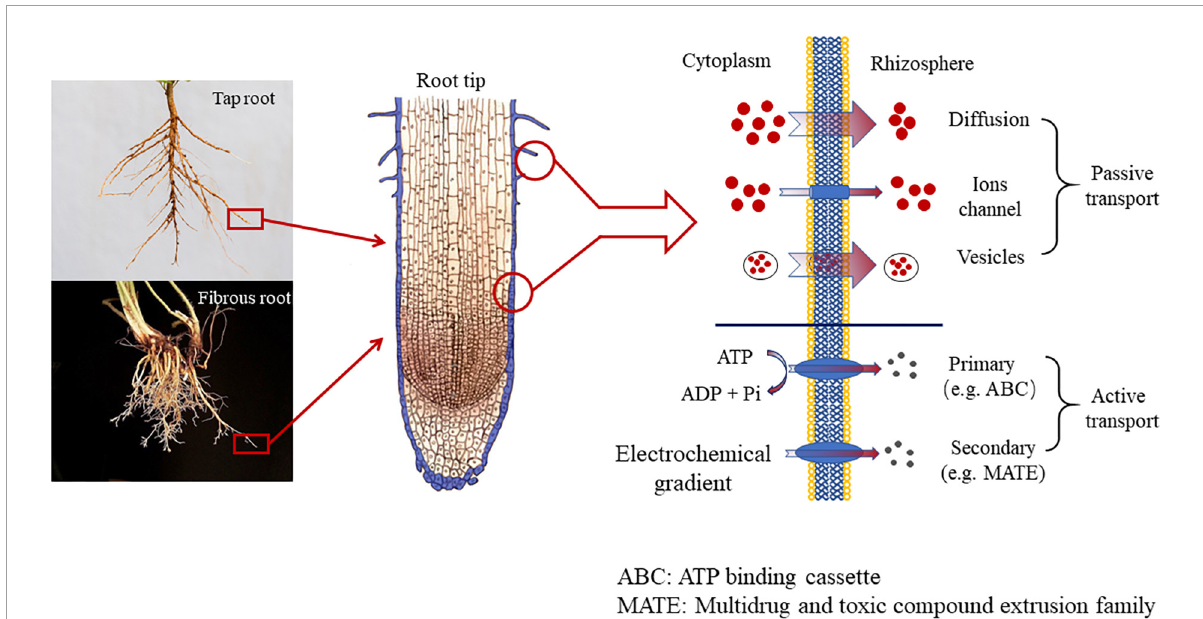
FIGURE1 The mechanism of root